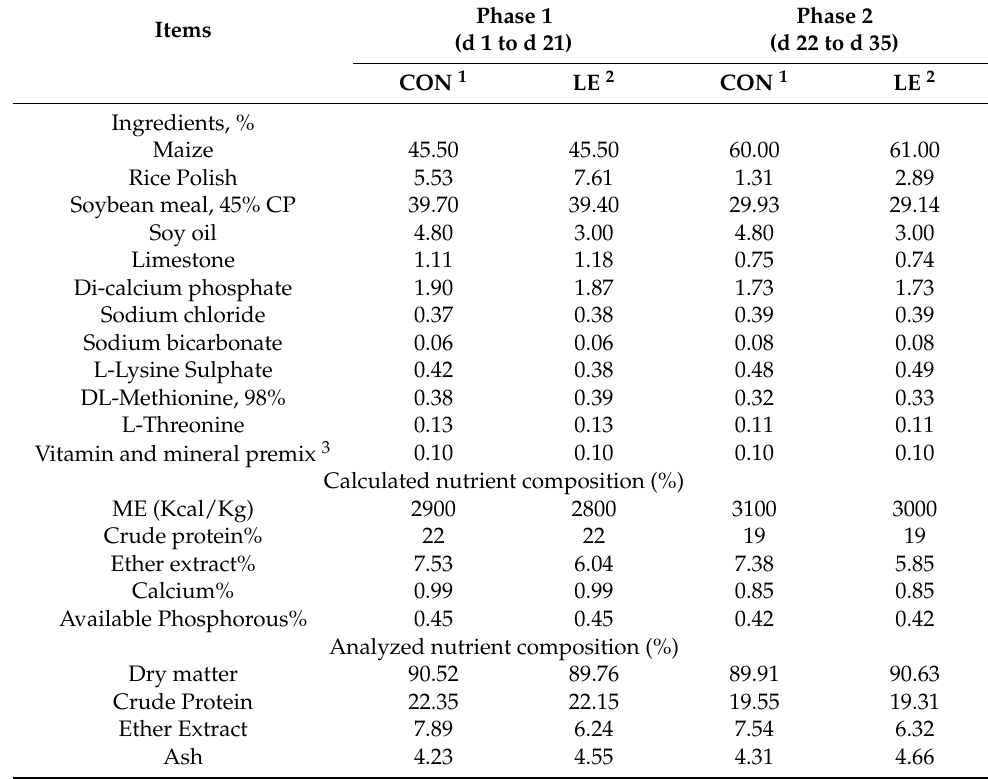
Phase 2 (d 22 to d 35)